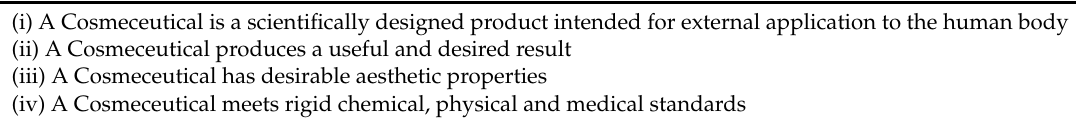
Table 1. Statements included in Reed´s cosmeceutical